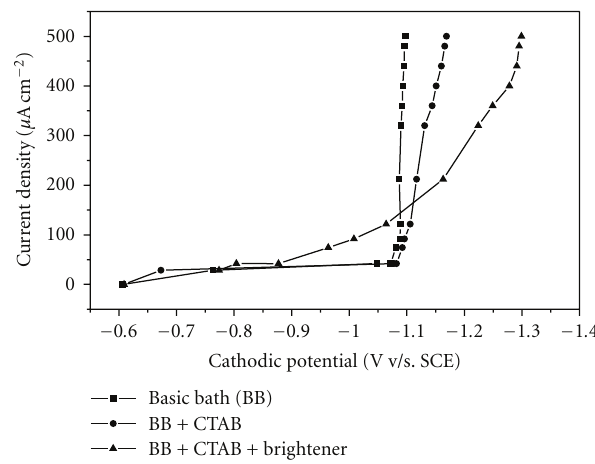
Figure 3: cathodic polarization curves in presence of di ff erent addition